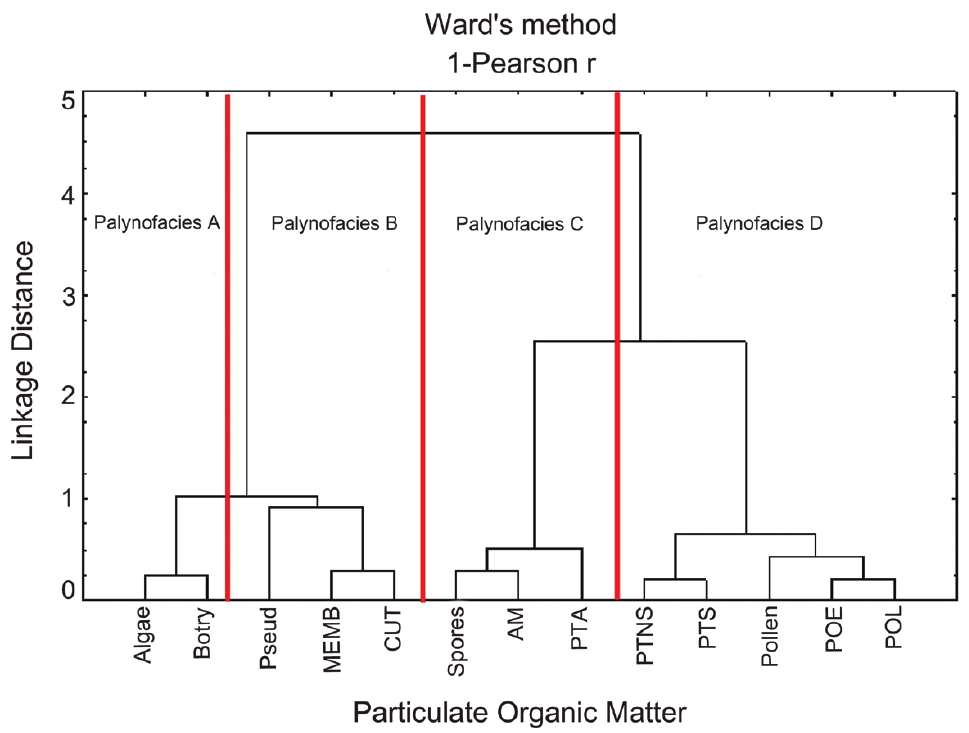
Fig. 6 - Dendrogram produced by cluster analysis R-mode for groups and subgroups of the POM from the T1 core (Mina do Museu). The red vertical lines divide the four palynofacies. Abbreviations are in accordance with Fig.